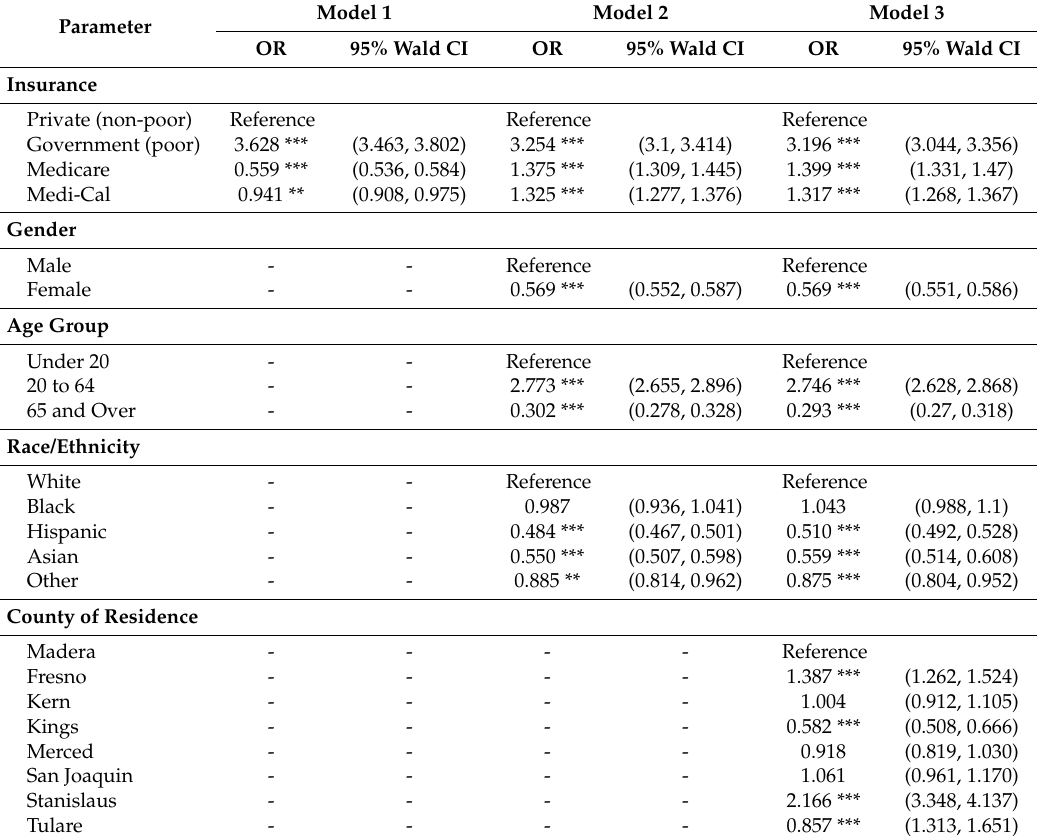
Table 3. Odds ratios (ORs) of mental health